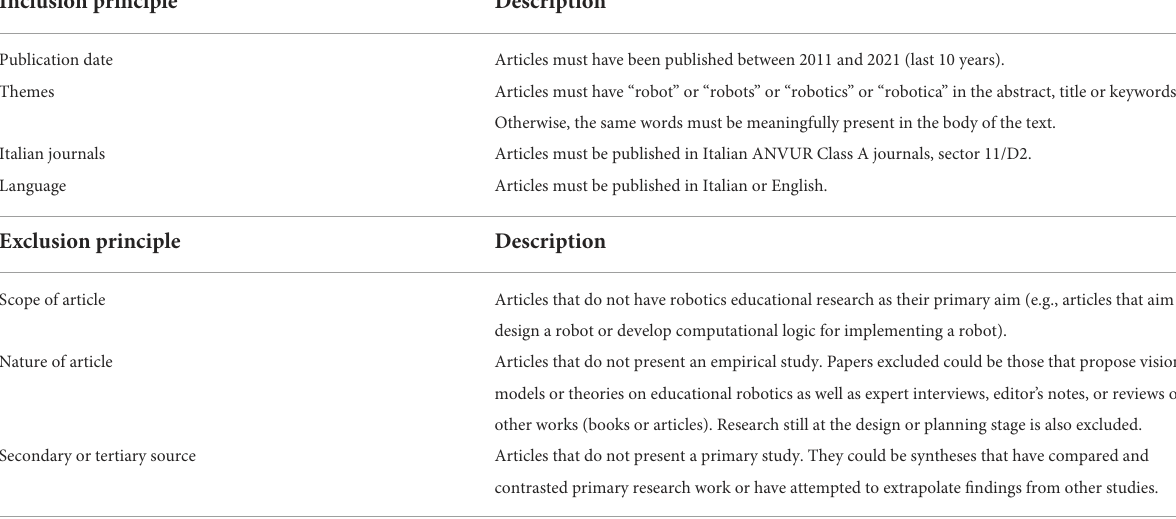
TABLE 2 Criteria for the inclusion and exclusion of